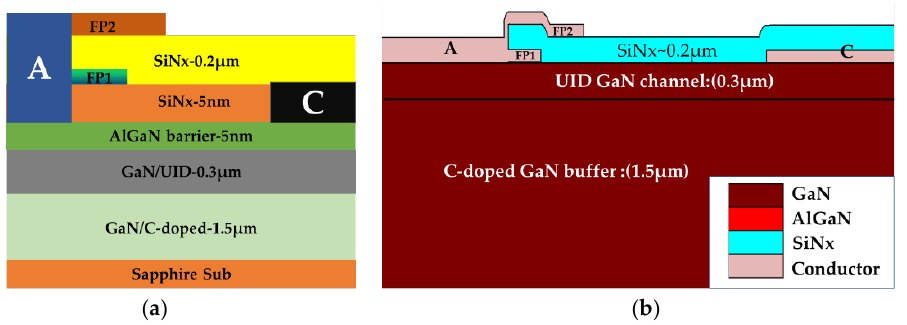
Figure 1. ( a ) Schematic of the Schottky barrier diode (SBD) for device under tests. ( b ) Schematic of the SBD from TCAD simulation.